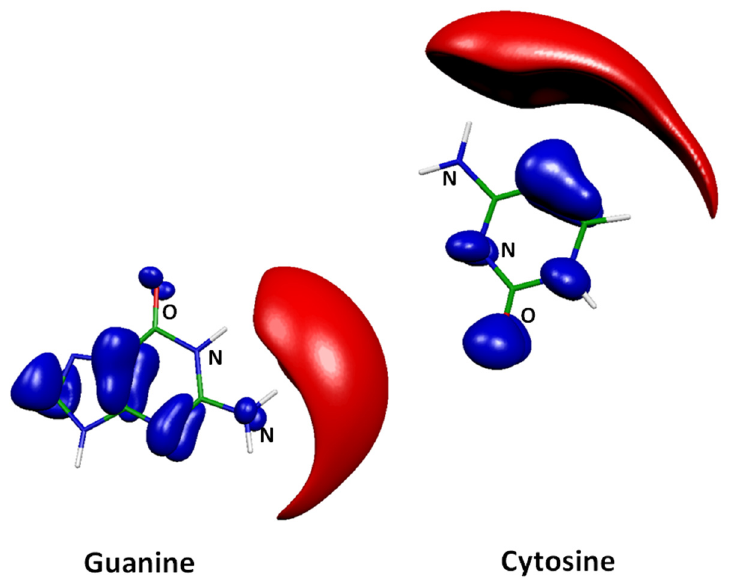
Figure 2. Main ELF x localization domains of the guanine and cytosine molecules computed at the M06-2X/6-311++G(3df, 2pd) level of theory. Color Code: blue: nucleophilic regions and red: electrophilic regions. Carbon atoms are in green, Nitrogen atoms in blue, Oxygen atoms in red and Hydrogen atoms in white.